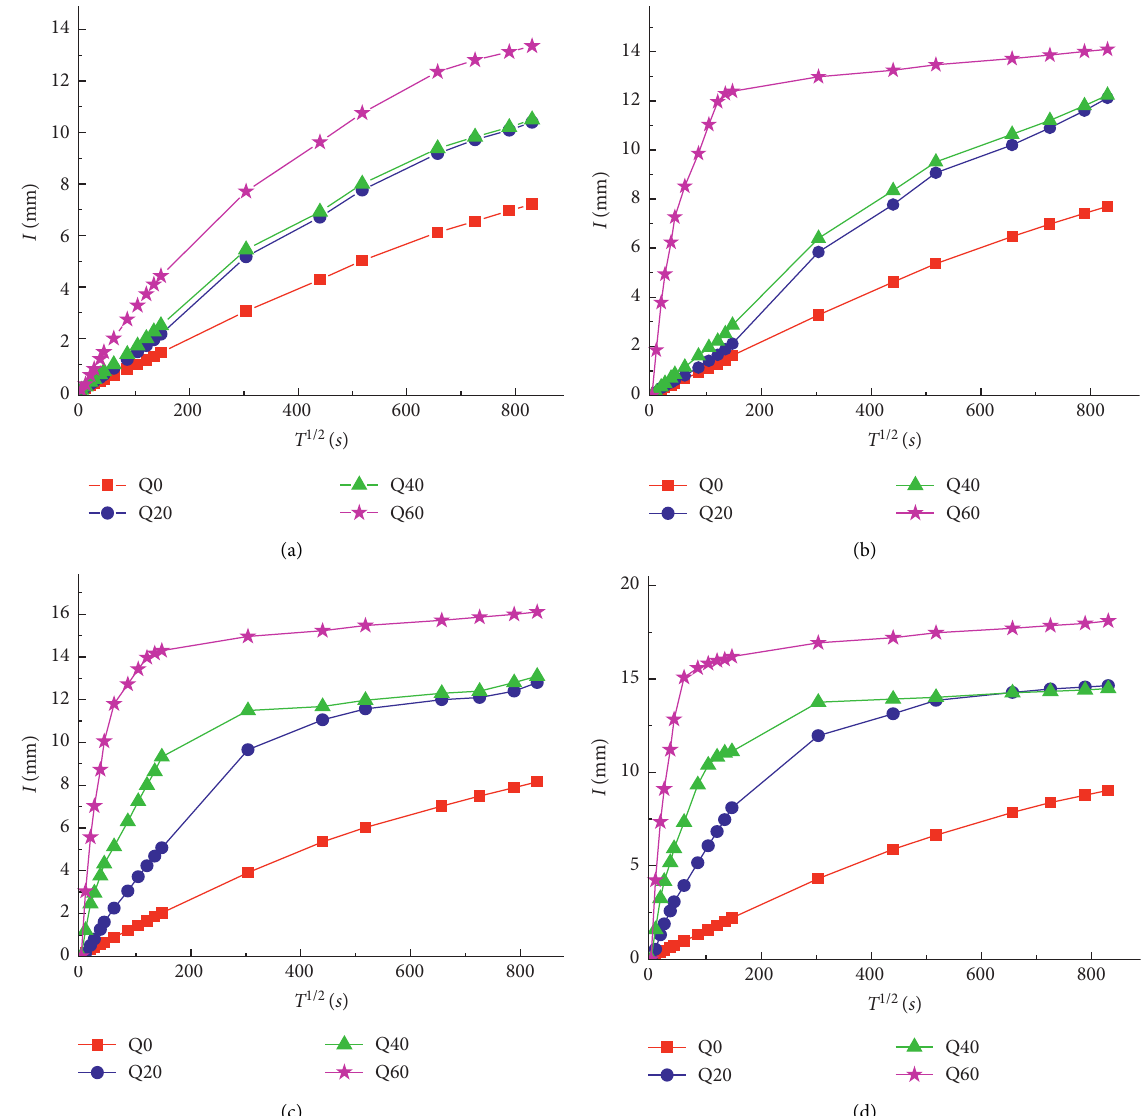
Figure 6: The curve of cumulative water absorption with the square root of time. (a) Freeze-thaw cycles of 0. (b) Freeze-thaw cycles of 25. (c) Freeze-thaw cycles of 50. (d) Freeze-thaw cycles of